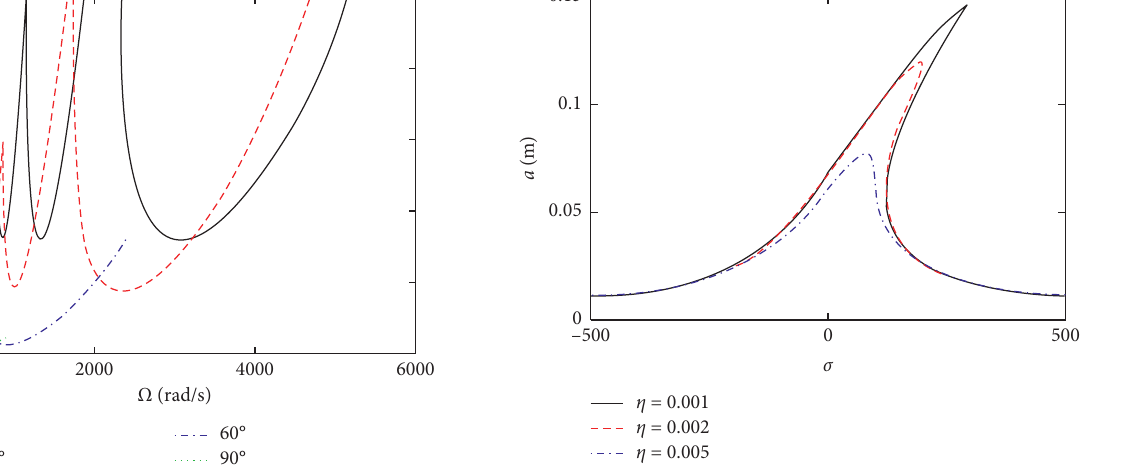
Figure 9: Effect of the ply angle on stability lobes.